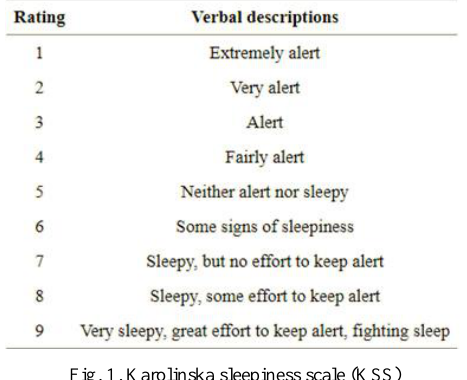
Fig. 1. Karolinska sleepiness scale